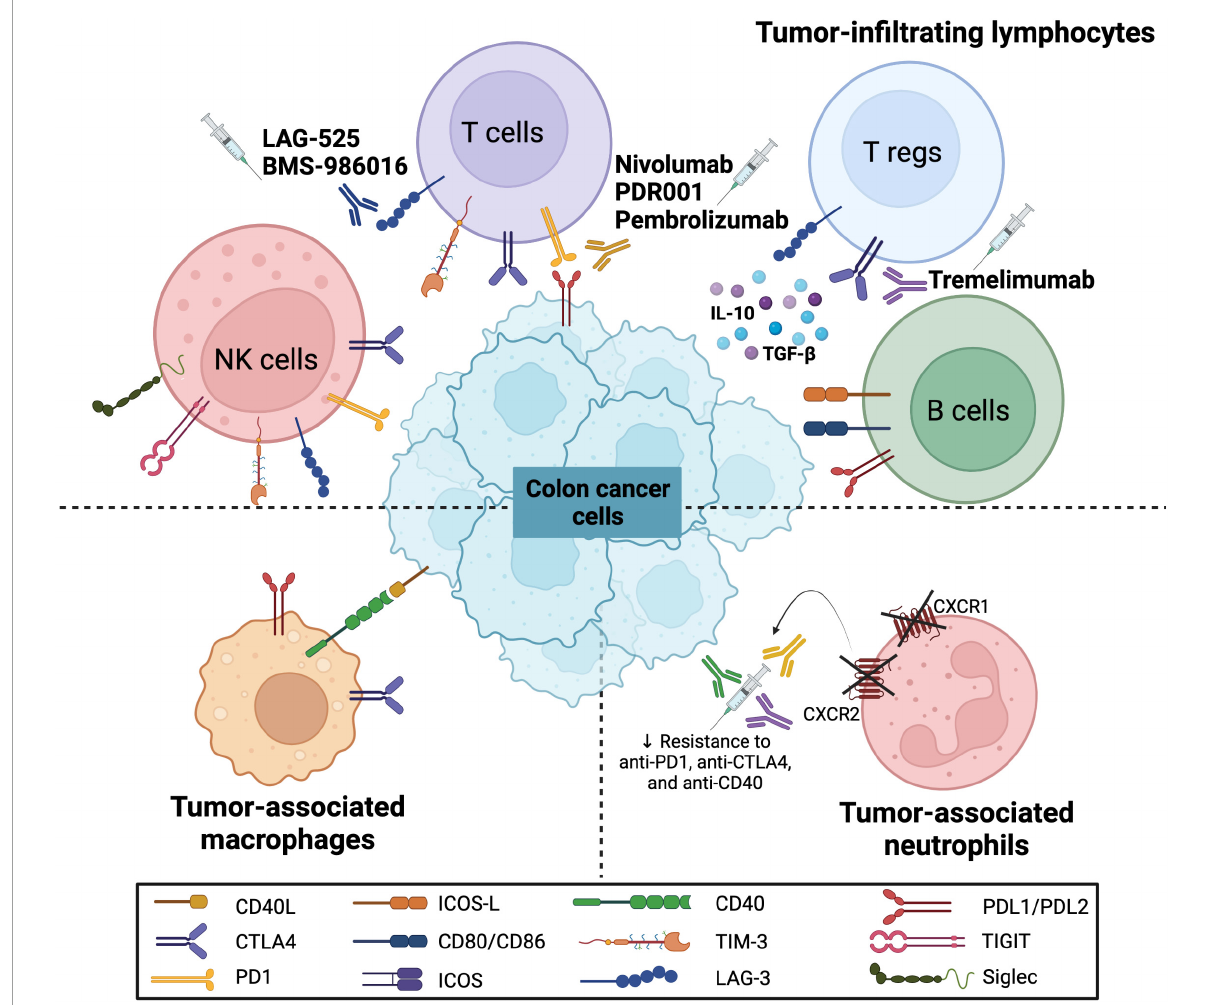
FIGURE1 Immune checkpoint molecules on various immune cells in colorectal cancer. The schematic representation shows the expression of various immune checkpoint molecules on immune cells that interact with colon cancer cells. These immune cells include tumor-infiltrating lymphocytes (TILs) such as natural killer (NK) cells, T cells, regulatory T cells (Tregs) and B cells, as well as tumor-associated macrophages (TAMs) and tumor-associated neutrophils (TANs). The molecules include programmed cell death (PD1) and its ligand (PDL1/PDL2), CD40 and its ligand (CD40L), CD80/CD86, cytotoxic T-lymphocyte associated protein 4 (CTLA4), T-cell immunoglobulin and mucin domain 3 (TIM-3), lymphocyte-activation gene 3 (LAG-3), identification of the inducible T cell co-stimulator (ICOS) and its ligand (ICOS-L), T cell immunoreceptor with Ig and ITIM domains (TIGIT) and sialic acid-binding immunoglobulin-type lectins (Siglec). Furthermore, several monoclonal antibodies have been introduced to target these molecules (LAG-3, PD/PD-L axis, and CTLA4) as potential CRC immunotherapeutic